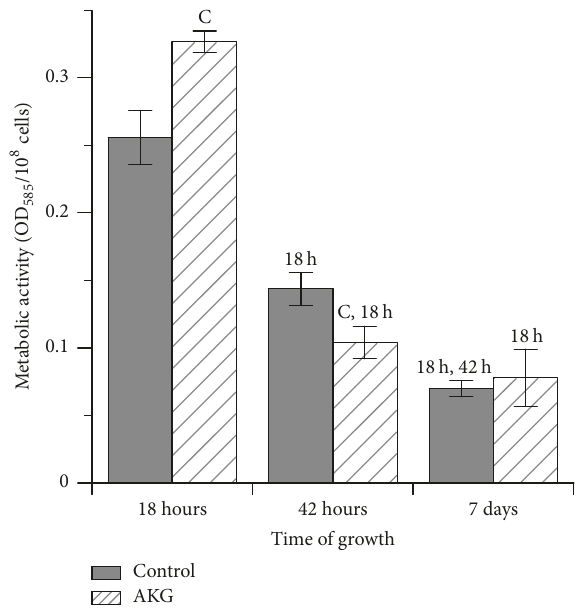
Figure4:Metabolicactivityof S.cerevisiae cellsgrownduring7days in the control medium or in the medium supplemented with 10mM AKG. Results are shown as means ± SEM ( 𝑛 = 5 -6). Statistic as in Figure